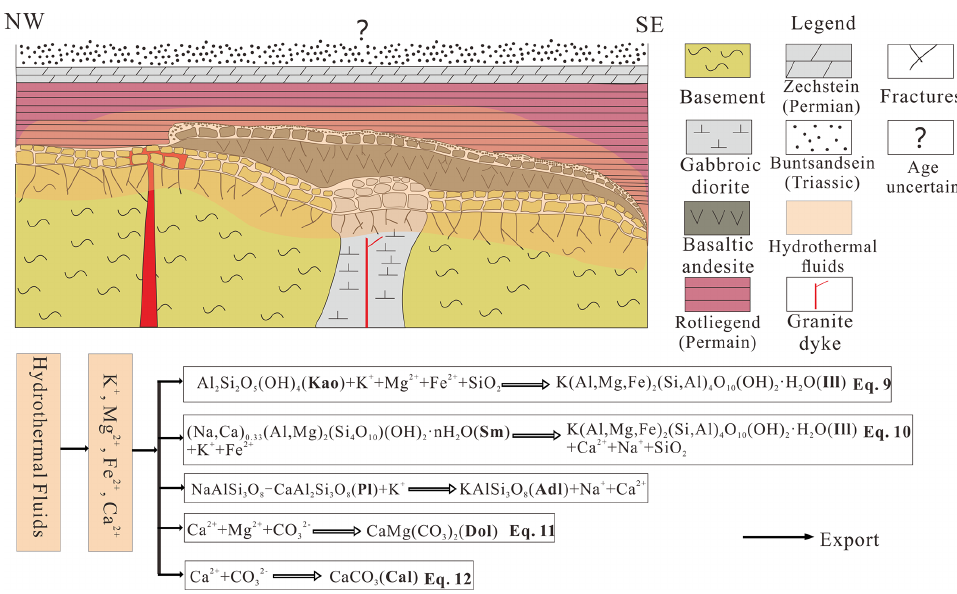
Figure 14. Reconstructed alteration model of the GA1 well in Sprendlinger Horst during burial in the Jurassic and Cretaceous. Adl denotes adularia; other abbreviations are given in the caption of Fig.